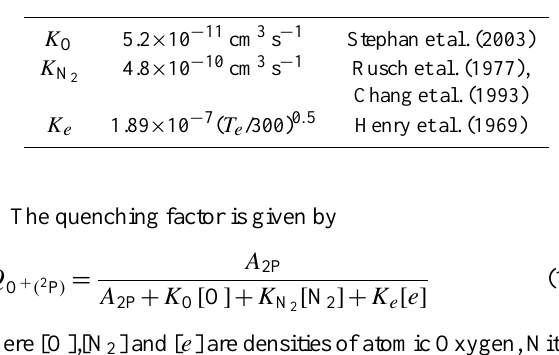
Table 1. Reaction rate